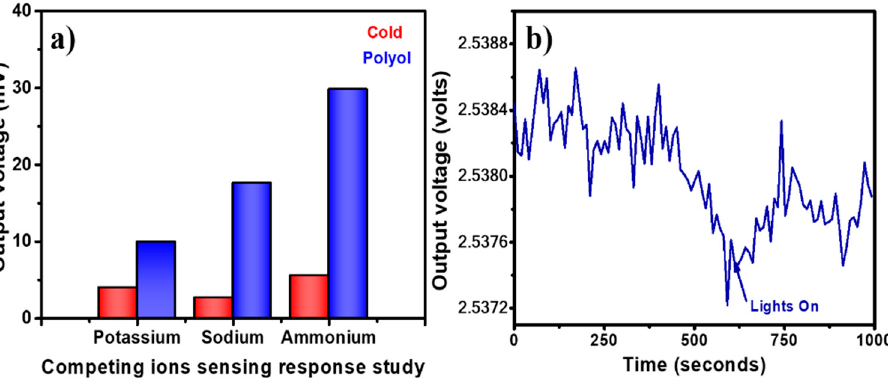
Figure 9. ( a ) Selectivity of Polyol synthesized product and cold synthesized product towards am- monium ion sensing, and ( b ) ambient light effect for PVP capped Ag-NPs synthesized by using polyol